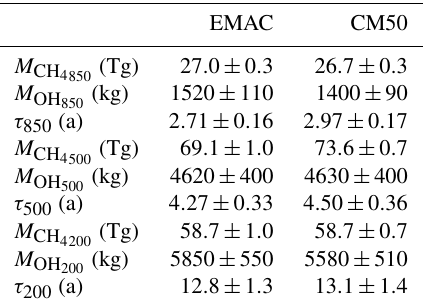
Table 7. The same as Table 6 but for the European